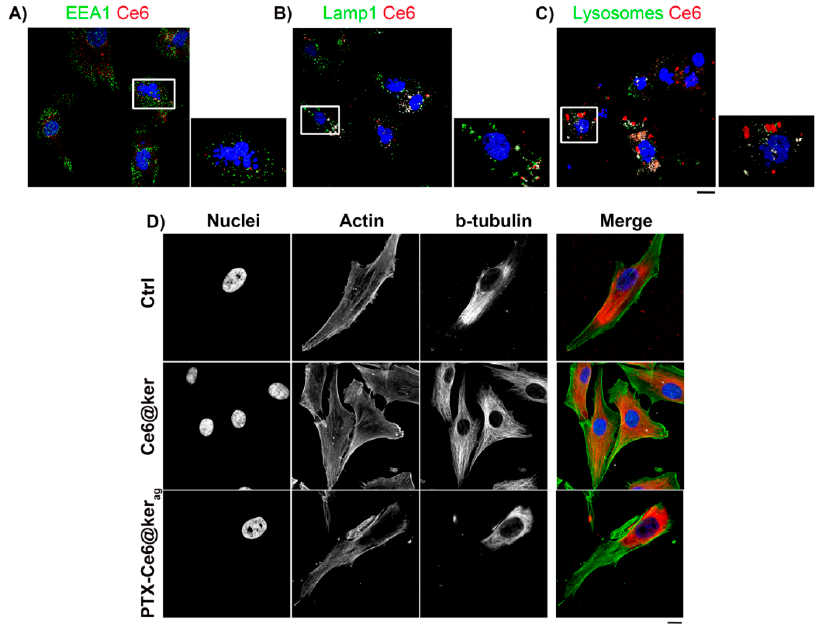
Figure 3. PTX-Ce6@ker ag localization and the effect of PTX on MG63 cells. ( A – C ) Representative confocal images of MG63 treated for 24 h with PTX-Ce6@ker ag and immunostained with EEA1, Lamp-1, and lysosomes, respectively (green channel in all pictures). The nuclei staining is shown in blue, the Ce6 signal in red, and colocalization in white; ( D ) Phalloidin (green channel) and β -tubulin (red channel) stainings were evaluated on MG63 at the end of the 24 h of treatment with Ce6@ker or PTX-Ce6@ker ag . Images are representative of at least three independent experiments. Scale bar: 20 µ m.